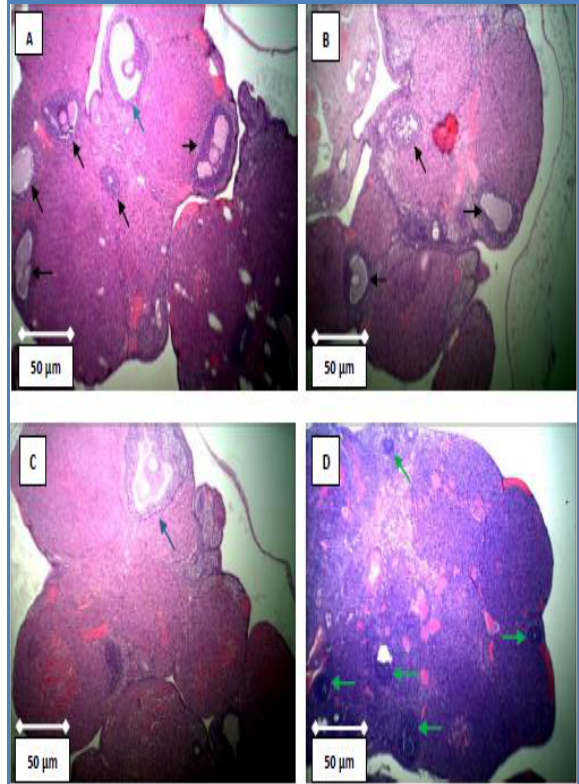
Figure, 2: Histopathological appearance of ovaries from Sprague Dawley rat after sacrificing and stained with Hematoxylin and Eosin double staining (H & E). (A) Control group showing normal ovarian texture that contains 5 follicles at different stages of growth (black arrows) with 1 fully matured graffian follicle (blue arrow), (B) Ovaries treated with 5 mg/kg of azorubine (AZ), showing 3 follicles at beginning stage of growth (black arrows) with no graffian follicle, (C) Ovaries treated with 10 mg/kg of AZ showing 1 fully grown graffian follicle (blue arrow) with no follicles at various stages, and (D) Ovaries treated with 20 mg/kg doses of AZ displaying no mature graffian follicle with 5 atretic ovarian follicles (green arrows). Scale bars showing magnification at